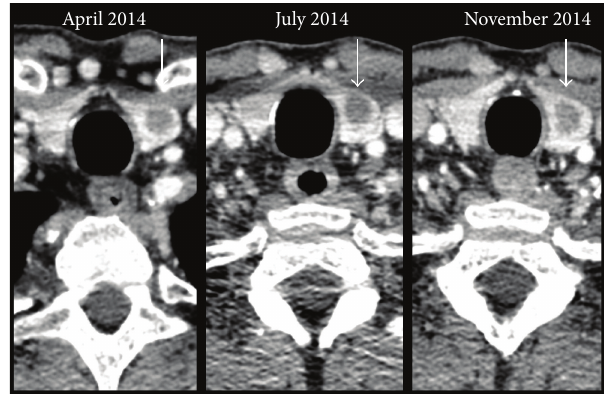
Figure 4: CT neck image of thyroid nodule (identified by white arrows) over